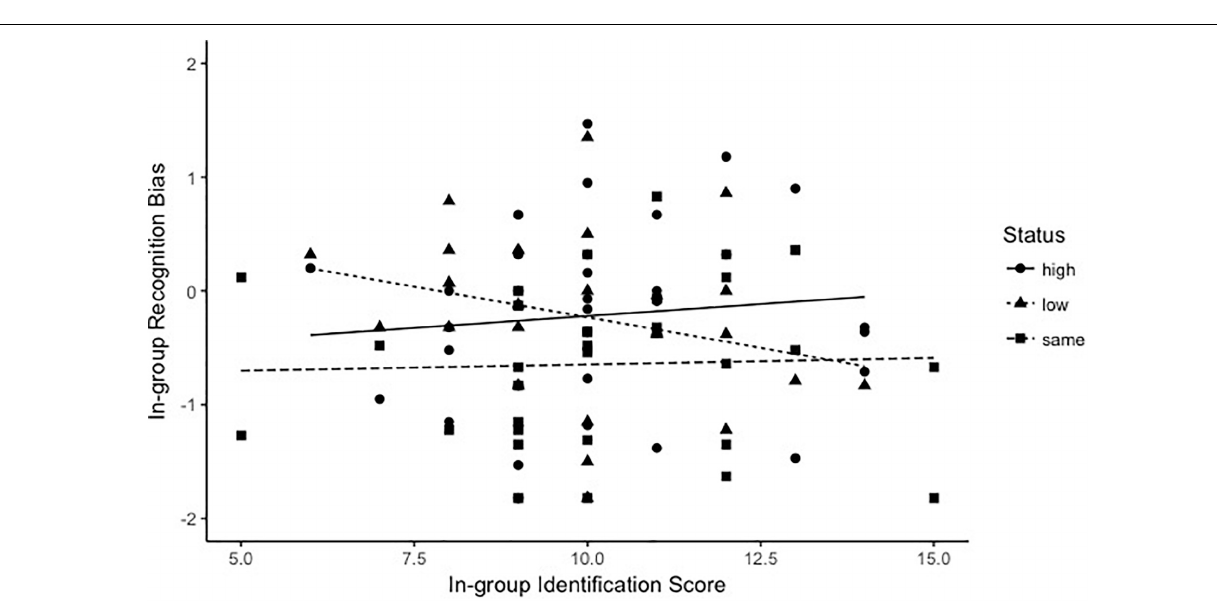
FIGURE 6 | The correlation between the in-group identification ( x- axis) and the in-group face recognition bias in d’ ( y- axis). The solid line refers to the group with the same power; the dotted line refers to the high group; and the dashed line refers to the low